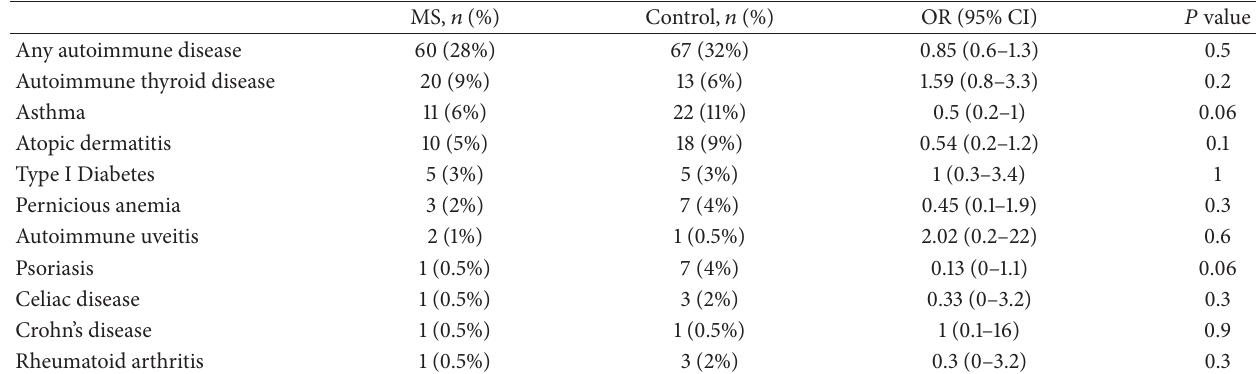
Table 2: Comorbid autoimmune disease prevalence and risk of